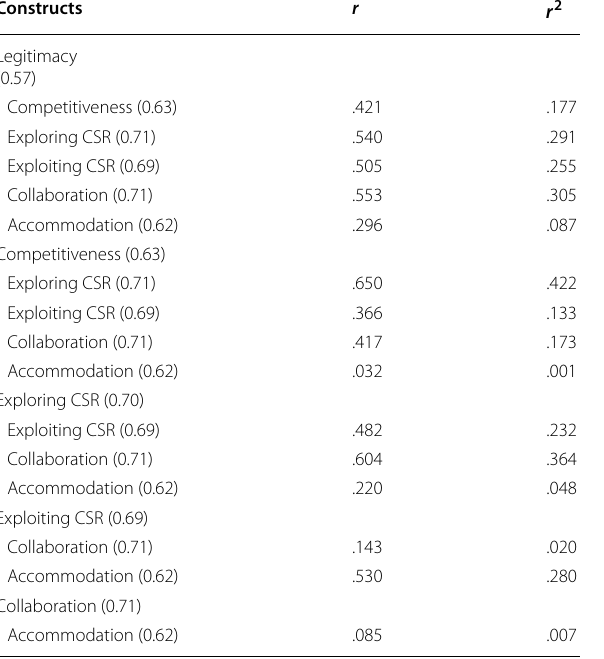
Table 6 Discriminant validity test: r